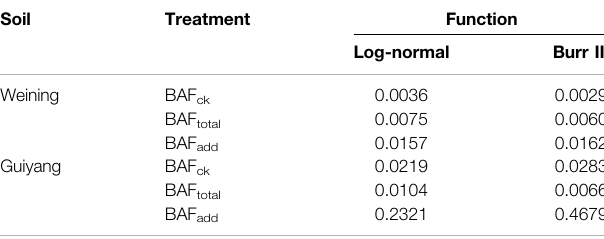
TABLE 1 | RMSE of soil Cd threshold calculated with two functions. Soil